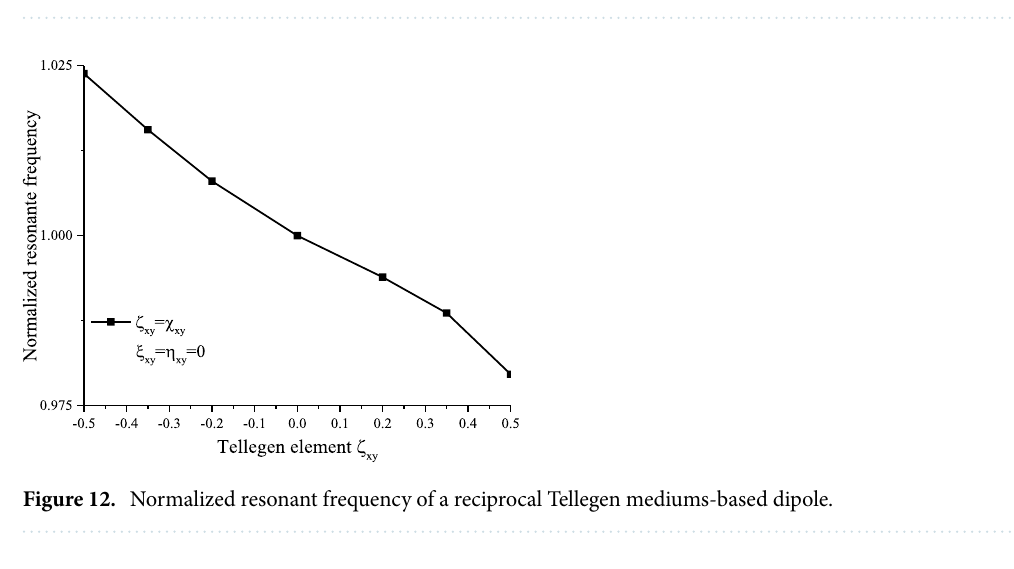
Figure 11. Effects of ( a ): Positive-reciprocal Tellegen and ( b ): negative-reciprocal Tellegen bianisotropic medium on the input impedance of the printed dipole.